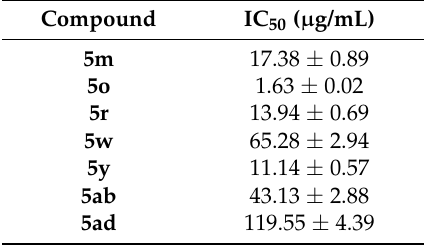
Table 4. IC 50 of the selected compounds on NIH/3T3 mouse embryonic fibroblast cell lines (ATCC CRL1658).